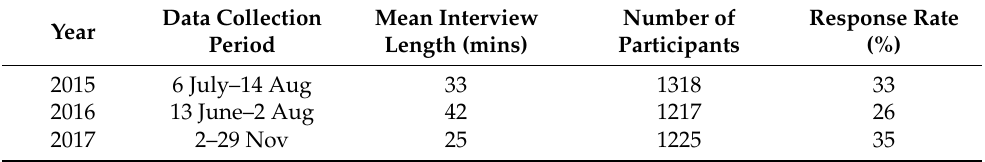
Table 1. Sampling